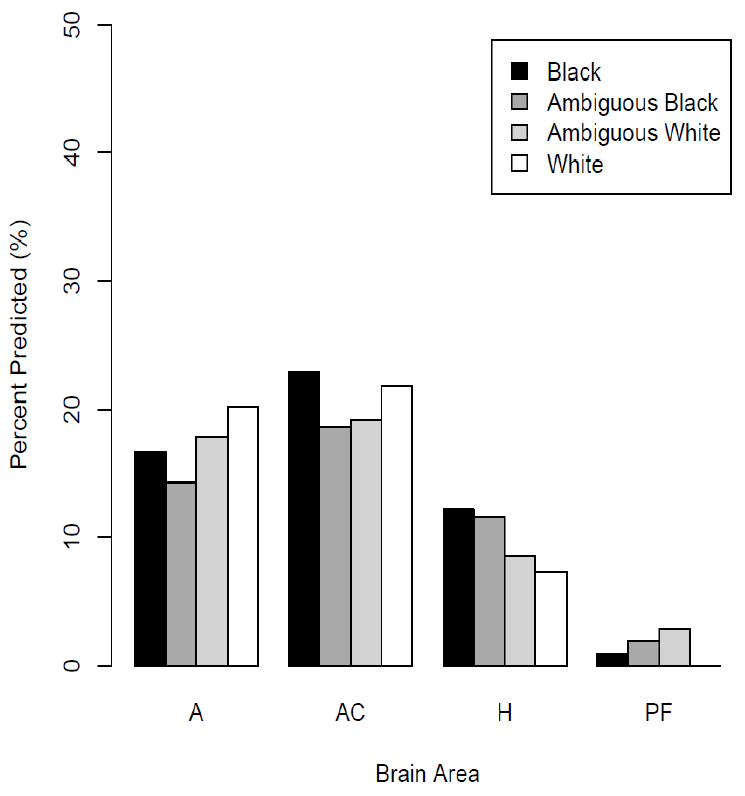
Figure 3. Percentages of neurons (SUA) significant for a test of the effect of stimulus race category on firing rate (relative to background firing) by brain area. The x -axis shows brain areas. The total neurons recorded were: Amygdala ( n = 168), ACC ( n = 188), Hippocampus ( n = 164), and the percentages stated are the corresponding percentages of these totals in each brain area. Note that there was no significant percentage of race-predictive neurons in the vmPFC out of the total ( n = 105). Table 1. Percentages of neurons with a significant response to stimulus race category (relative to background firing rates) for each brain area. Asterisks denote significant proportions ( p < 0.05). Percentages are the number of neurons with a significant test in each area divided by the total number in the area multiplied by